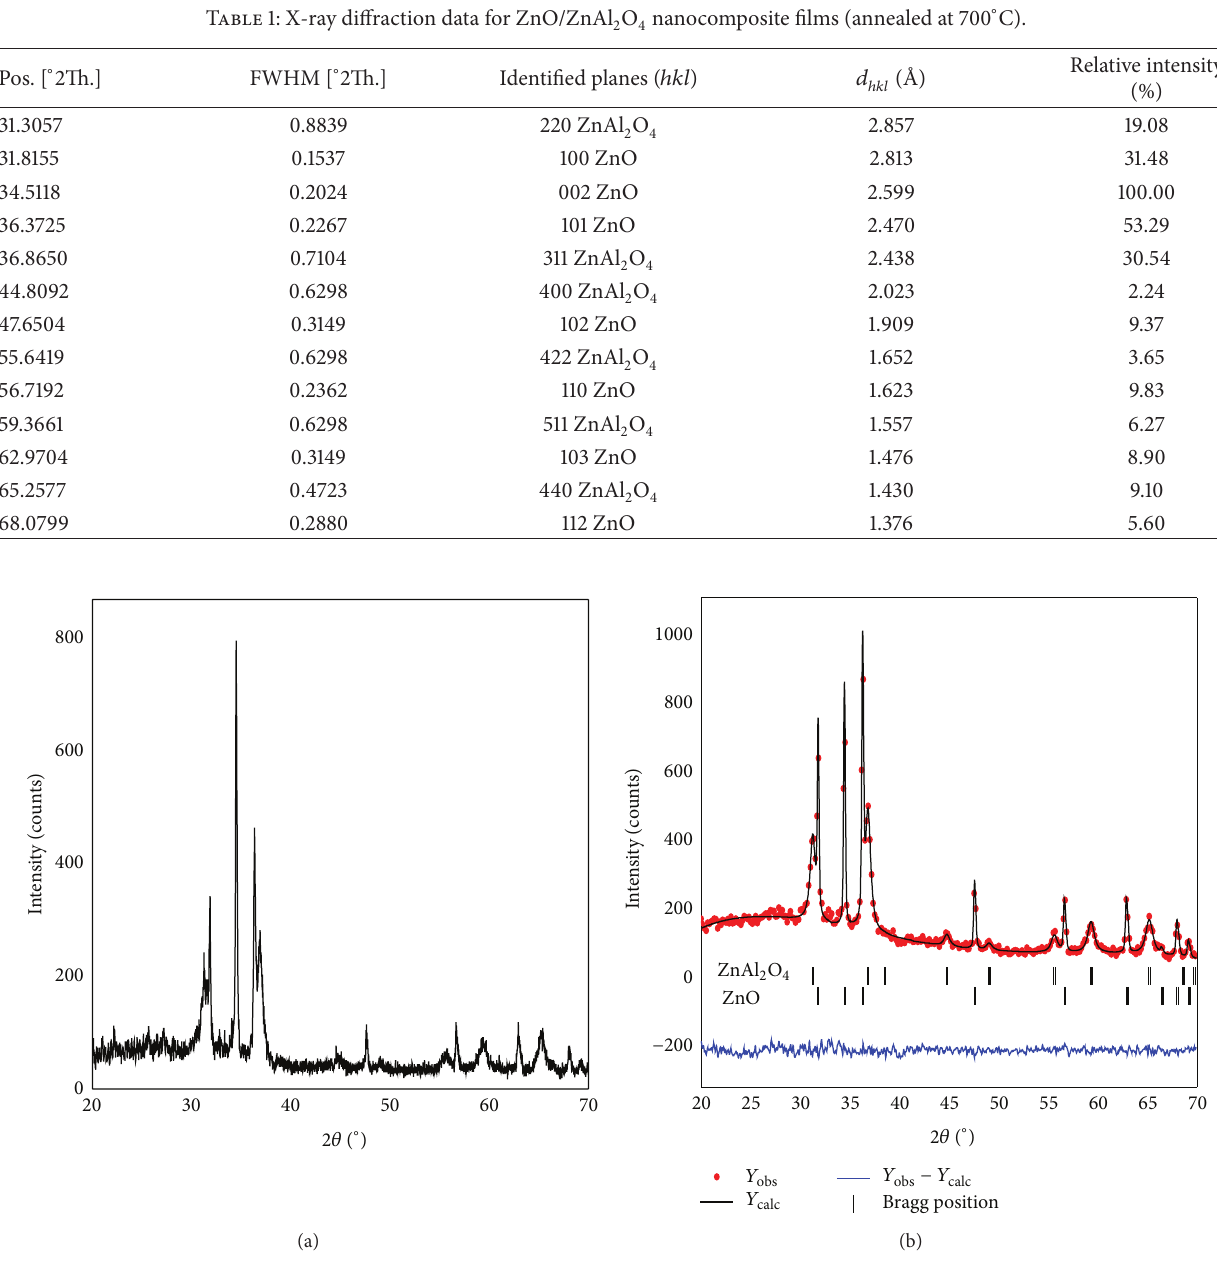
Figure 3: Typical XRD pattern of the ZnO/ZnAl 2 O 4 nanocomposite films annealed during 1h at (a) 700 ∘ C and (b) 650 ∘ C.